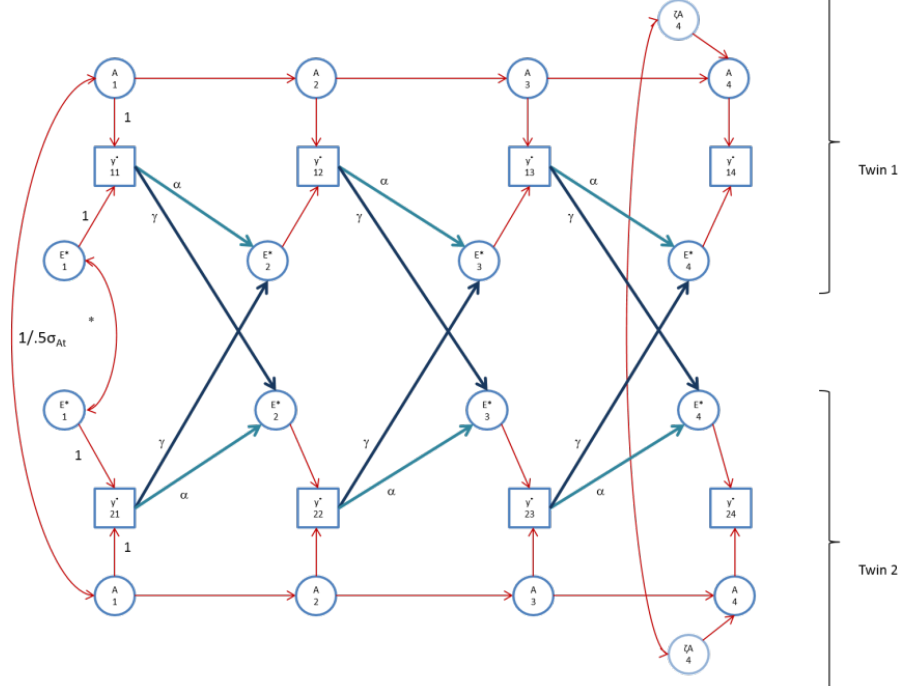
Figure 4. The AE* simplex model with Ph->E transmission as fitted to perfIQ. Time specific effects are not shown. Note that in perfIQ, time specific effects were found to be environmental (time specific genetic variance was